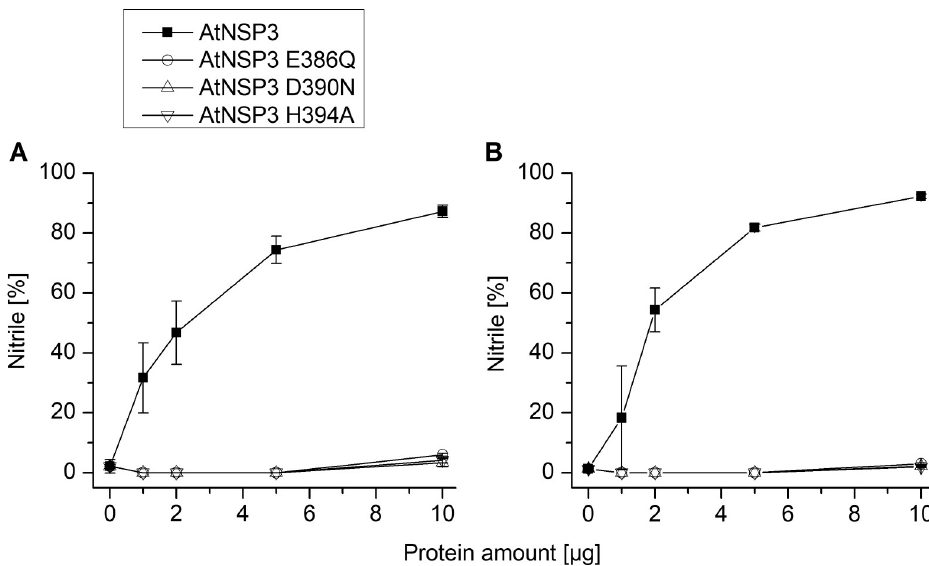
Fig 6. Activity of AtNSP3 mutants with substitutions of proposed iron-binding residues. Purified proteins were incubated with allylglucosinolate (A) or benzylglucosinolate (B) and myrosinase in 50 mM MES buffer, pH 6.0, supplemented with 0.01 mM Fe 2+ for 40 min. Activity is expressed as the proportion of simple nitrile formed relative to the total amount (nmol) of detected breakdown products. Shown are means ± SD of N = 3 independent expression